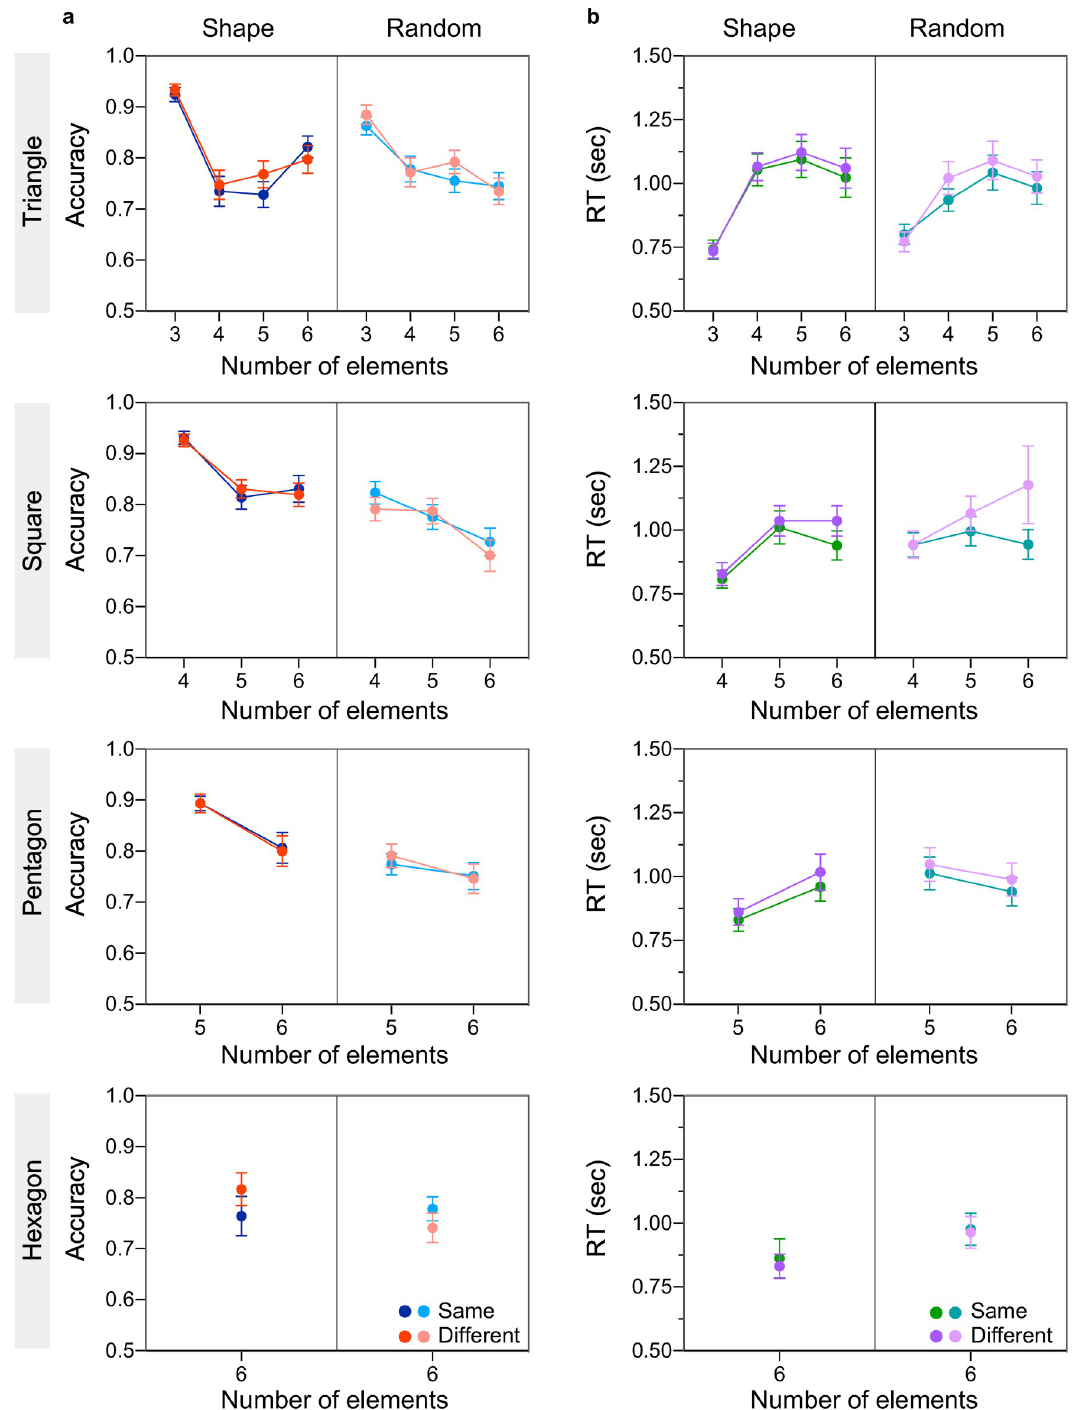
Fig 4. Experiment 2 results (effect of luminance polarity). (a) Accuracy and (b) reaction time are plotted as a function of number of elements for simple shape (left side of each panel) and random (right side of each panel) configurations, and for same (blue/green symbols) and different (red/purple symbols) luminance poalrity conditions. Top to bottom panels correspond to different simple shape configurations: Equilateral triangle (top panel), square, pentagons and hexagon (bottom panel) configuration. The error bars indicate standard error of the mean ( ± 1